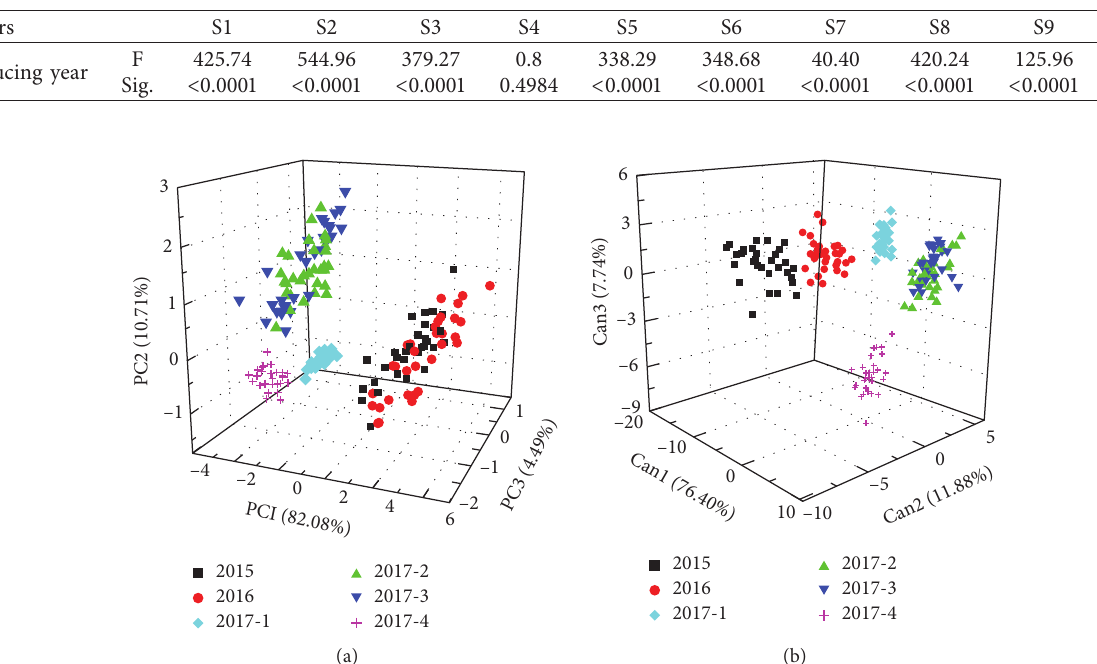
Figure 2: (a) PCA and (b) CDA scatter plot of dried Lycium fruits produced in different years based on E-nose responses.